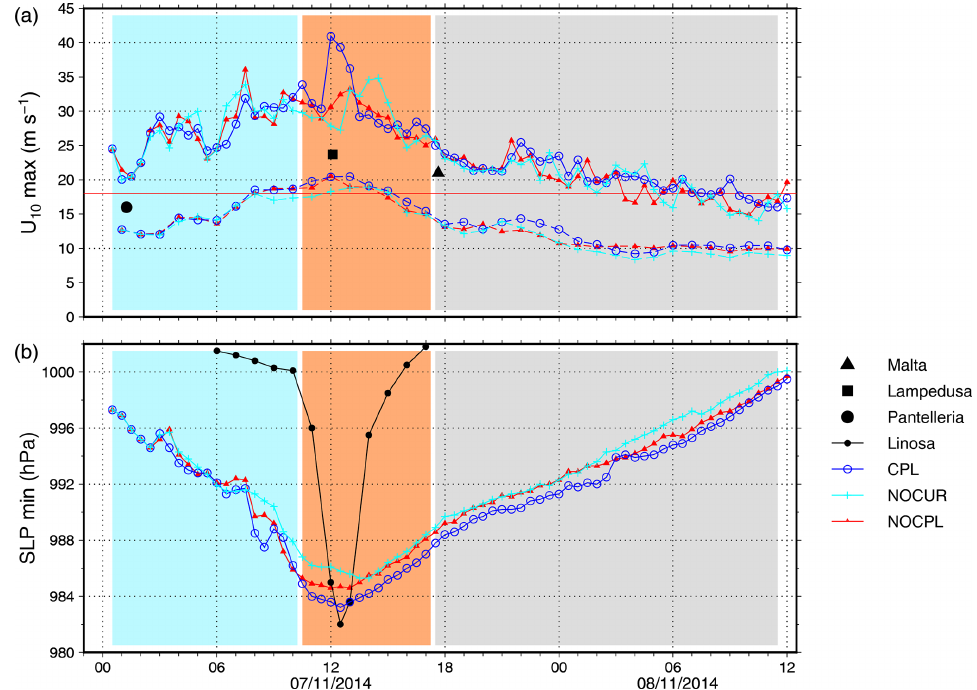
Figure 4. Time series of the maximum of the 10m wind speed and of the 10m wind averaged over a 100km radius around the cyclone centre (a) and minimum sea-level pressure (b) as obtained in the different simulations on 7 November and 8 November until 12:00UTC. The thin red line in (a) indicates the 18ms − 1 wind speed threshold. The background shading (here and in the following time-series plots) indicates the development (light blue), mature (orange) and decay (grey) phases. The observations of SLP in Linosa (black plain circles) are shown for comparison in (b) ; the observations of wind speed from Malta, Lampedusa and Pantelleria are shown in (a) – see text.